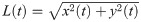
(a) Distance L(t)=x2(t)+y2(t) travelled by cargoes as a function of time extracted from trajectories generated by the non-Markovian rate model with the parameters Ta=1s−1, μ = 1.4, τd = 1 s (Eq (2)) and (b) for the Markovian rate model. Other parameters are given in the Methods. Trajectories were generated with fractional Gaussian noise (fGn) and Gaussian noise (GN). One trajectory for each model is shown without fGn and GN for comparison.